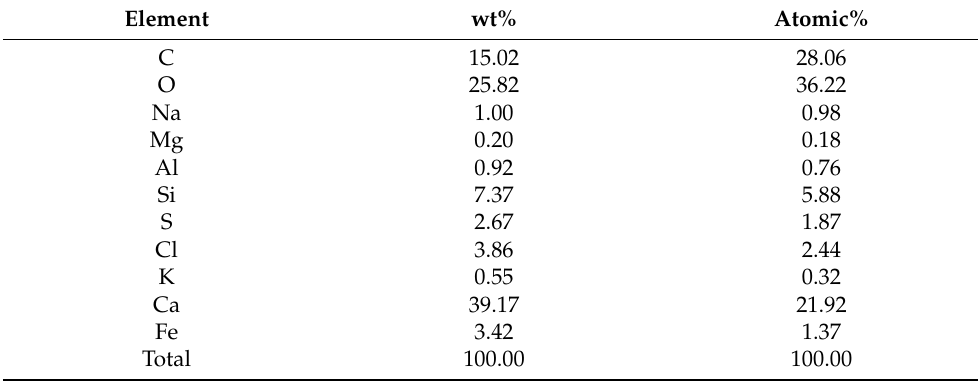
Table 6. Element content of the cement matrix (Spectrum